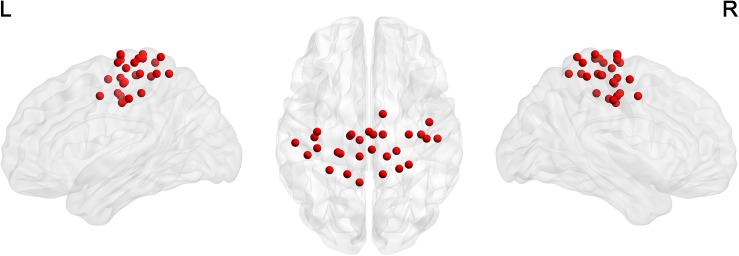
The distribution of 29 ROIs in the sensorimotor network (Power et al., 2011) was visualized in surface space using the BrainNet Viewer (Xia et al., 2013).